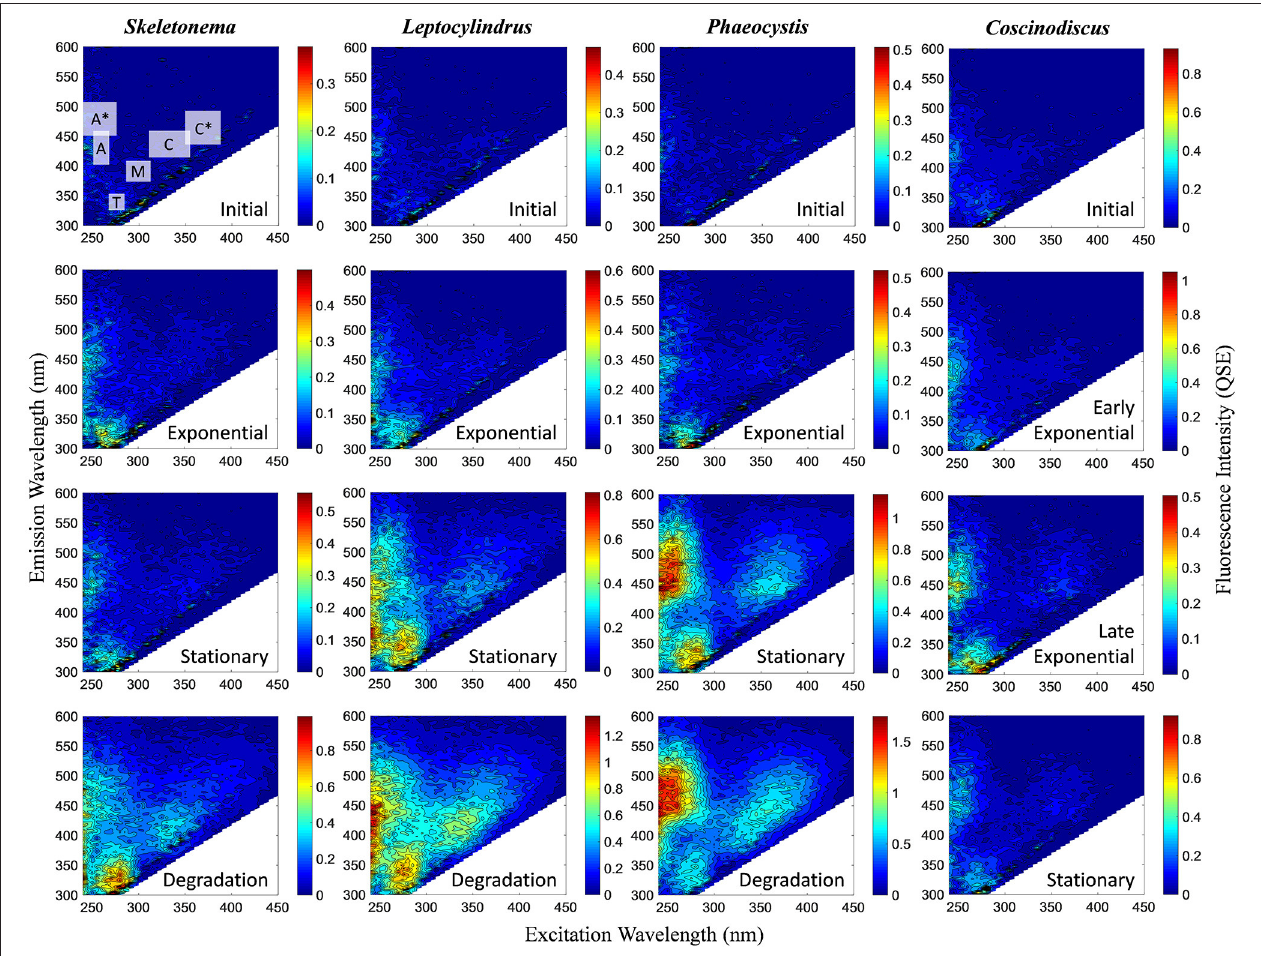
FIGURE 4 | Representative excitation-emission matrices (EEMs) of CDOM fluorescence for genera Skeletonema , Leptocylindrus , and Phaeocystis at initial, exponential, stationary, and degradation phases and for Coscinodiscus sp. at initial, early exponential, late exponential, and stationary growth phases. Color bars are presented in quinine sulfate equivalence (QSE) where 1 QSE = 1 ppb quinine sulfate equivalents. Note different scales for color bars for each EEM. Major peak regions of EEMs are indicated in the initial time point for Skeletonema sp.